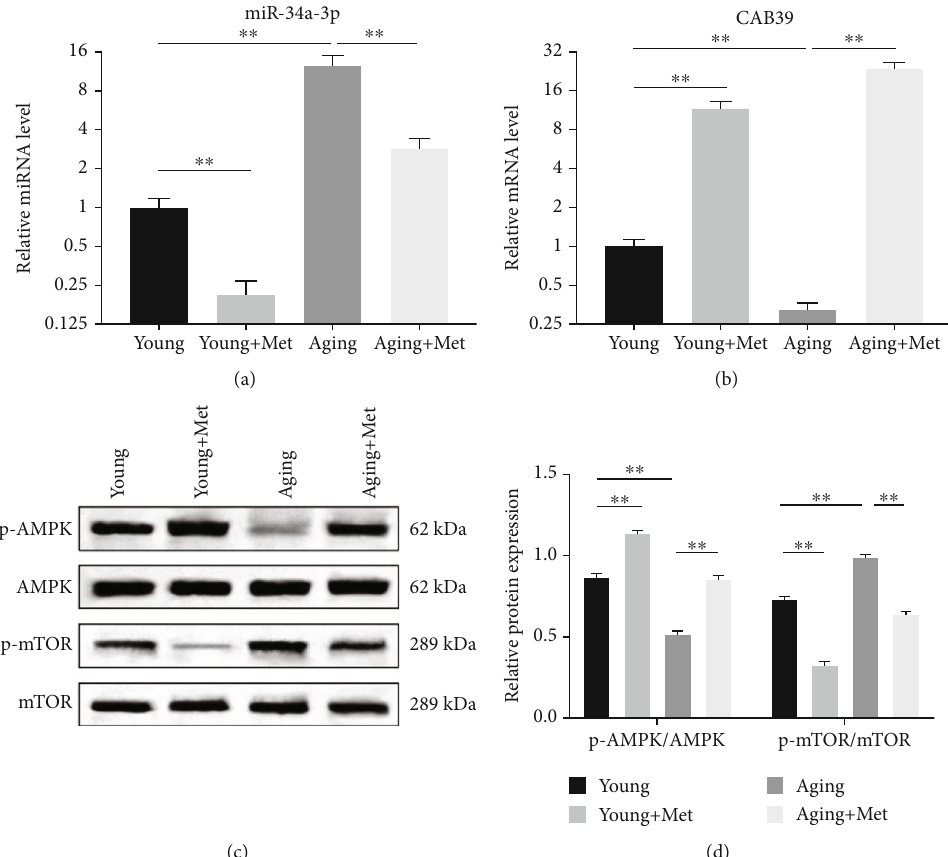
Figure 4: Metformin inhibits miR-34a-3p expression and activates the AMPK/mTOR signaling pathway in DPSCs. Young and aging DPSCs were treated with 100 μ M metformin for 48 h. (a) Relative expression levels of miR-34a-3p and (b) CAB39 were determined by RT-qPCR. (c) Representative blots of p-AMPK, AMPK, p-mTOR, and mTOR protein expression levels. (d) Quantitative analysis of the proportion of p- AMPK/AMPK and p-mTOR/mTOR. Data are expressed as the mean ± standard deviation ( n = 3 ). ∗∗ p < 0 : 01 , with comparisons indicated by